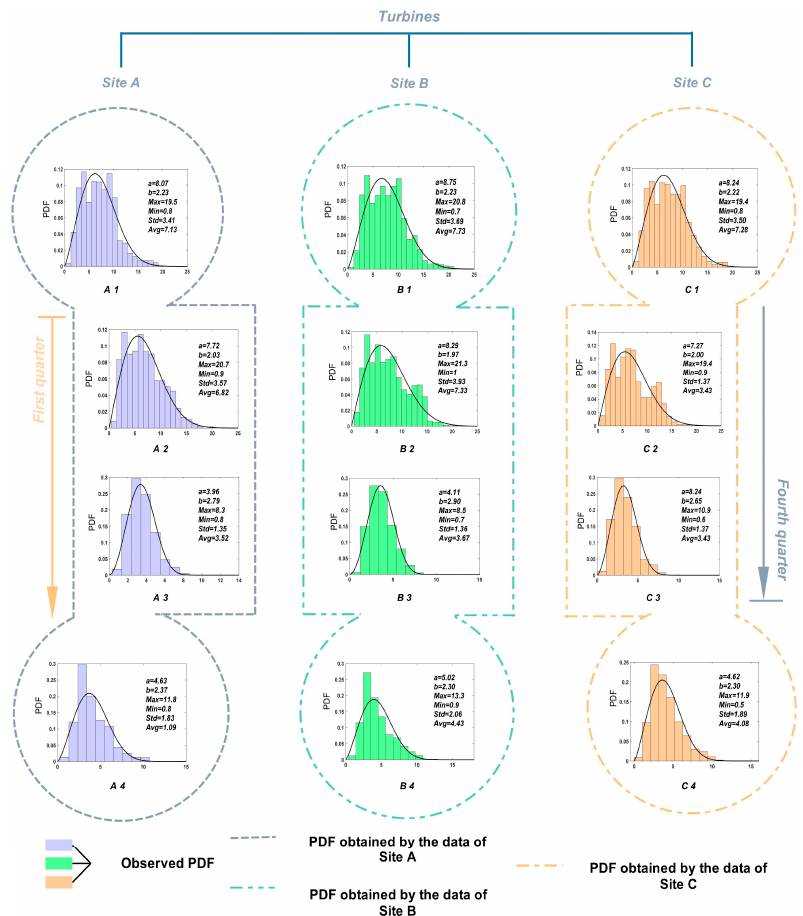
Figure 4. Weibull wind speed distribution (scale parameter a and shape parameter b) and basic statistical measures. (Max/Min: maximum/minimum; Avg.: average; Std.: standard deviation. A – C: three different sites. 1 – 4: four quarters).